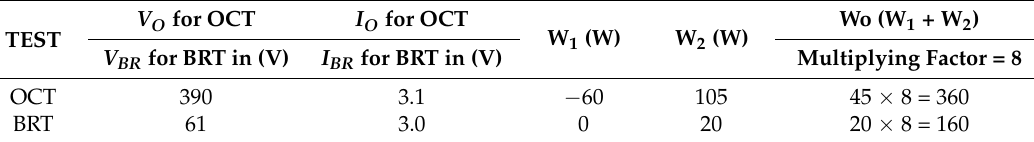
Table 4. Testing of the three-phase proposed induction machine (IM).